Question: Author a descriptive caption for the visualization shown.
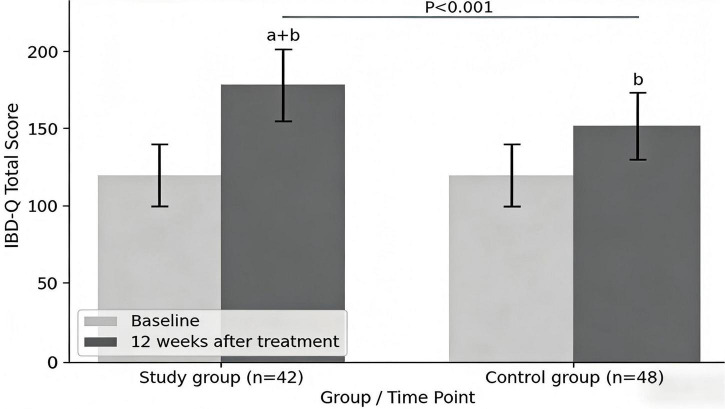
Answer: Comparison of IBD-Q total scores between the two groups at baseline and 12 weeks after treatment. a P < 0.05 vs. control group; b P < 0.05 vs. baseline (0 weeks).